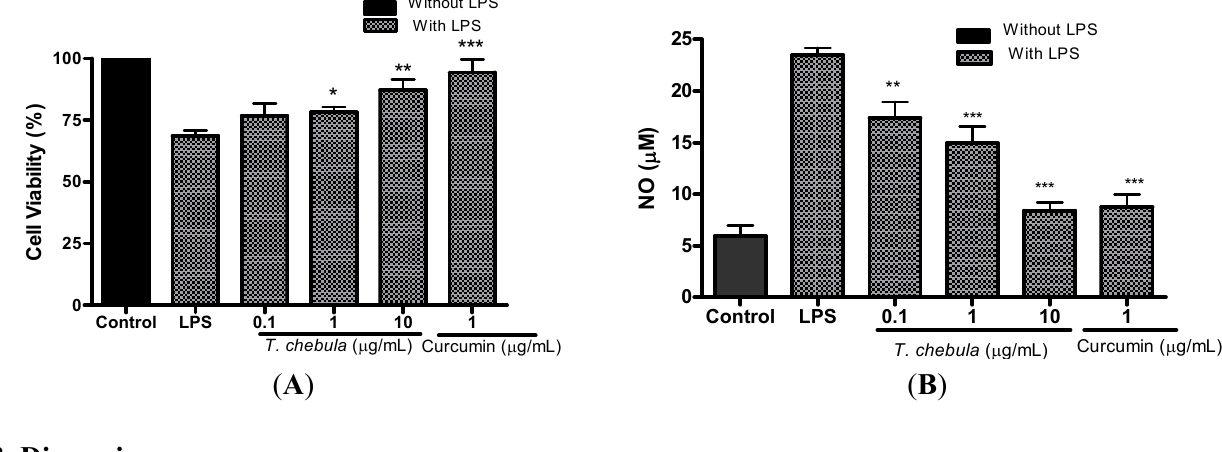
Figure 4. Effect of T. chebula extract on LPS-induced cell death and NO inhibition assay. BV2 cells were exposed to LPS (1 μ g/mL) for 24 h. Different concentrations of T. chebula extract were treated 2 h before and during LPS exposure. ( A ) Cell viability was measured by MTT assay. Control group served as 100%, and data obtained in other groups were calculated as percentage of control accordingly. ( B ) Cell-conditioned supernatants were collected and the production of NO in the supernatants was measured using Griess reagent. NO production was calculated by using standard nitrite. * p < 0.05, ** p < 0.01, and *** p <